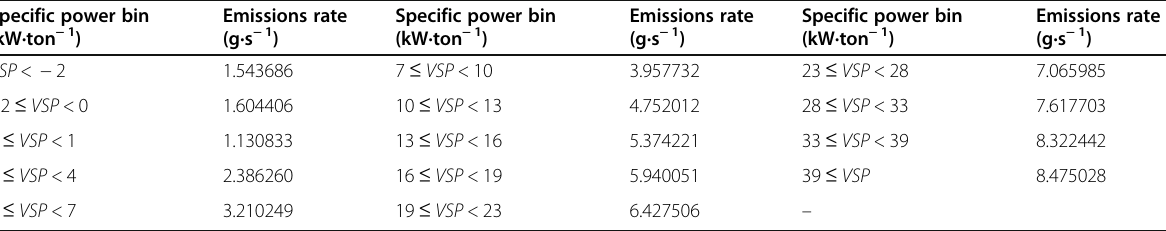
Table 3 Average emissions rates of CO 2 of fuel vehicles in different specific power bins